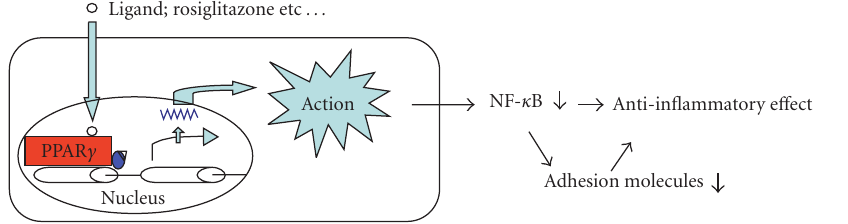
Figure 3: PPAR γ exerts anti-inflammatory e ff ects. Schematic representation showing molecular pathways mediating the anti-inflammatory e ff ects of PPAR γ ligands.